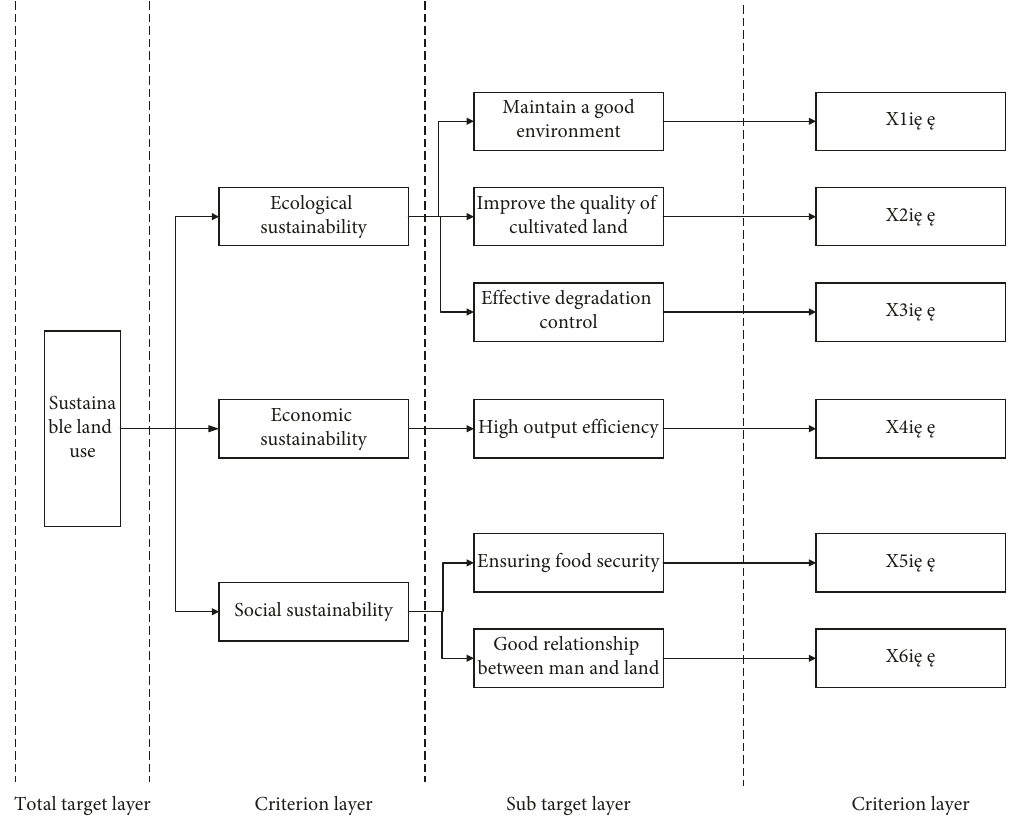
Figure 4: Framework of evaluation index system.